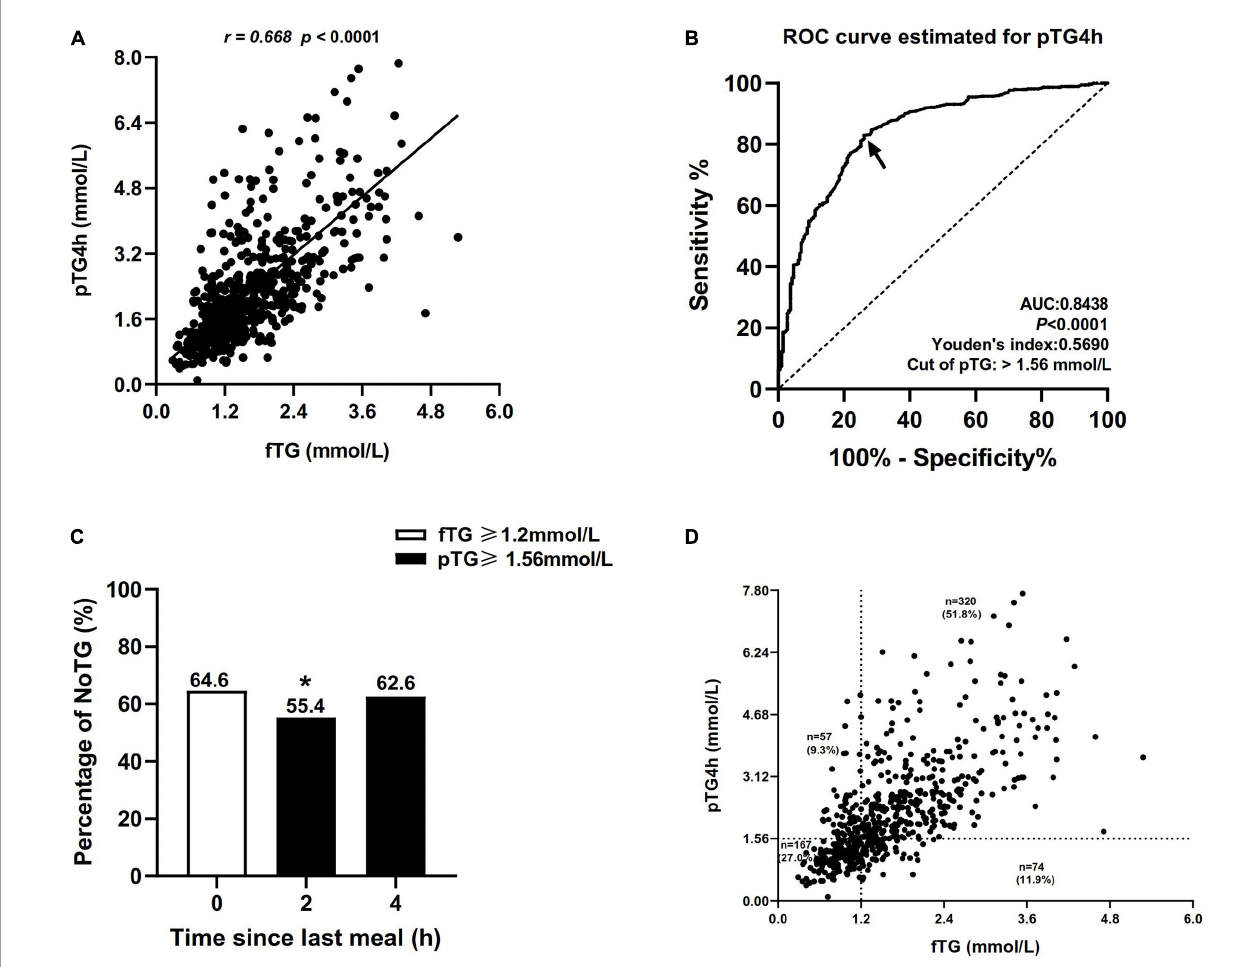
FIGURE2 Comparisons of the percentages of non-optimal triglyceride (NoTG) at different time-points. (A) Correlation between the level of fasting TG (fTG) and pTG4h. (B) Receiver operating characteristic (ROC) analysis and Youden’s index determined a cut-off value for postprandial TG level at 4h (pTG4h) after a daily meal; the cut-off value was indicated by a solid arrow. (C) Comparisons of the percentages of NoTG at different time-points according to the different cut-off values. (D) Distribution of the levels of fTG and pTG4h in all subjects. * P < 0.05 when compared with the fasting state. Optimal triglyceride (OTG) group: fasting TG < 1.2 mmol/L. Non-optimal triglyceride (NoTG) group: fasting TG ≥ 1.2 mmol/L. Values are represented as n (%) as